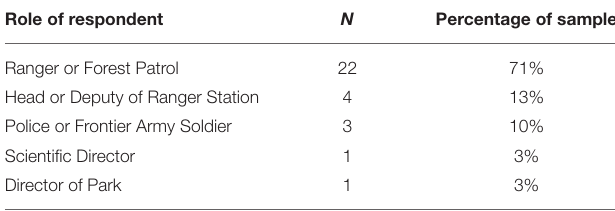
TABLE 1 | Sample ( N =